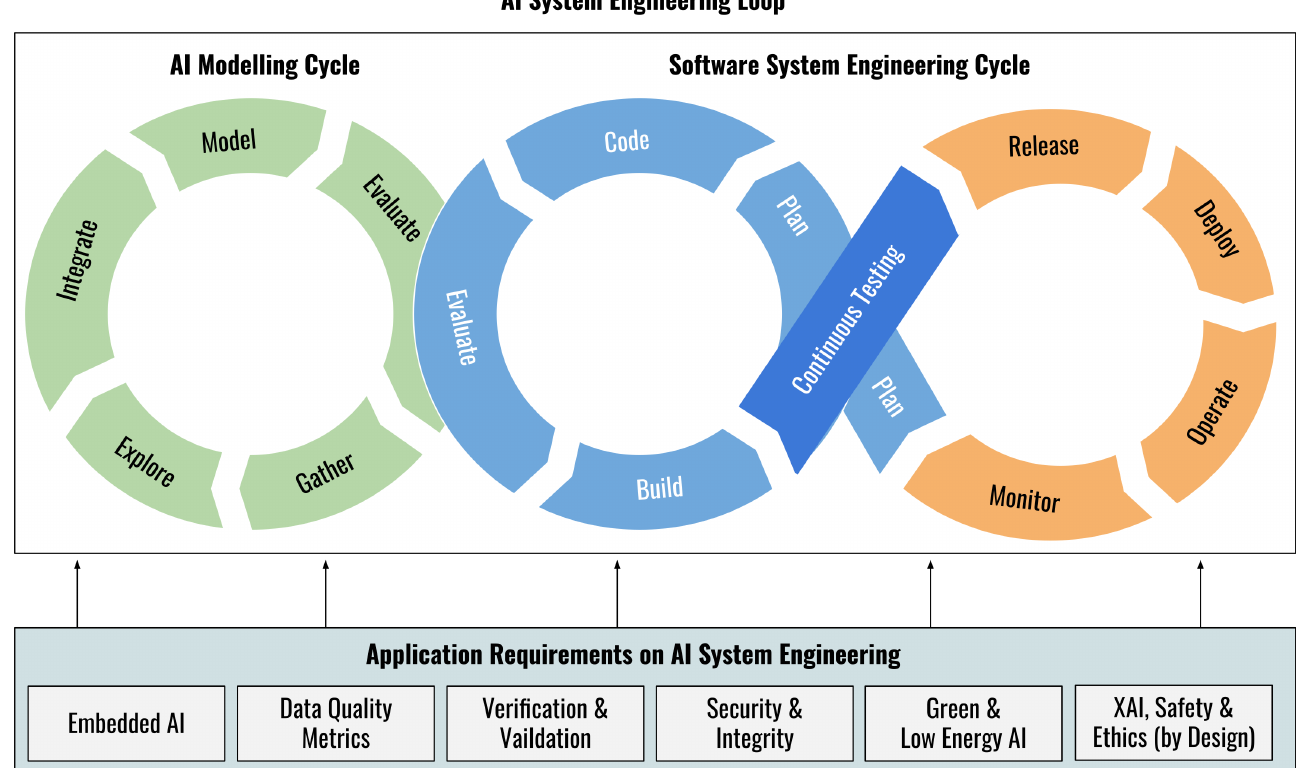
Figure 1. Artificial Intelligence (AI) System Engineering Lifecyle comprised of AI modelling cycle and software system development